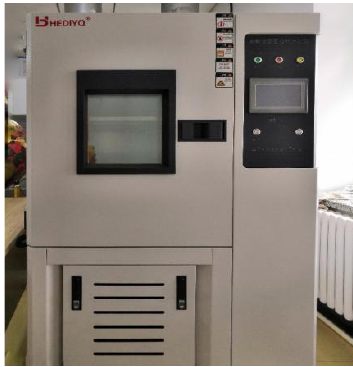
Figure 2. The thermostatic chamber of constant humidity. (Shanghai Hengding Instrument & Equip- ment Factory, HDGDSJ-150).